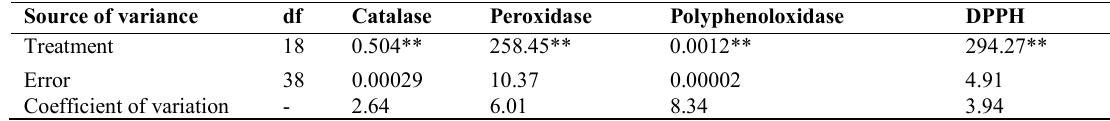
Table 1 . Variance analysis of antioxidant enzymes in samples treated by EMS based on randomized complete design.